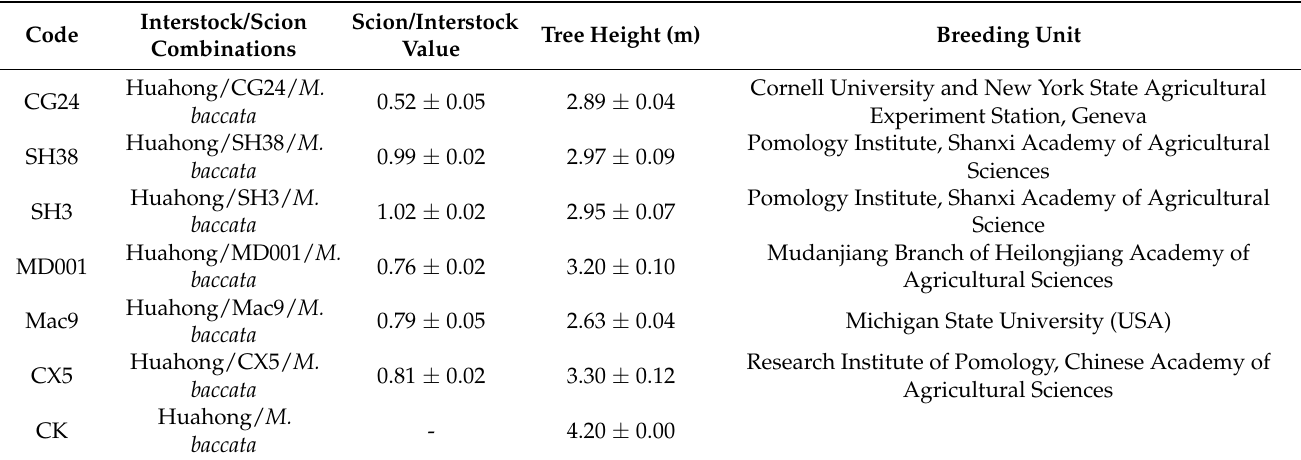
Table 1. Information of dwarf interstock combinations. Scion/interstock value and tree height expressed as average and standard error (mean ± SE; n =